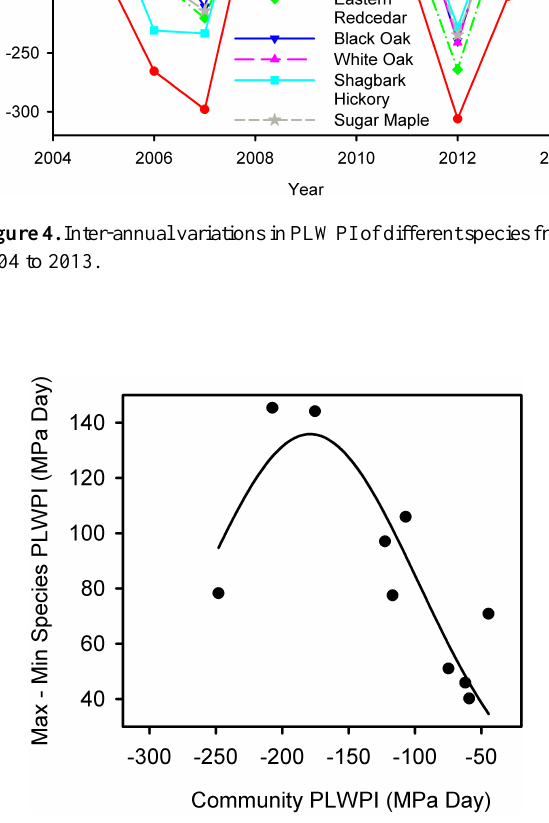
Figure 5. The difference between the maximum and minimum PLWPI among the six species studied as a function of the commu- nity PLWPI. The community PLWPI serves as a measure of overall water stress of a year. This figure shows that species differences in PLWPI reach the maximum at an intermediate level of water